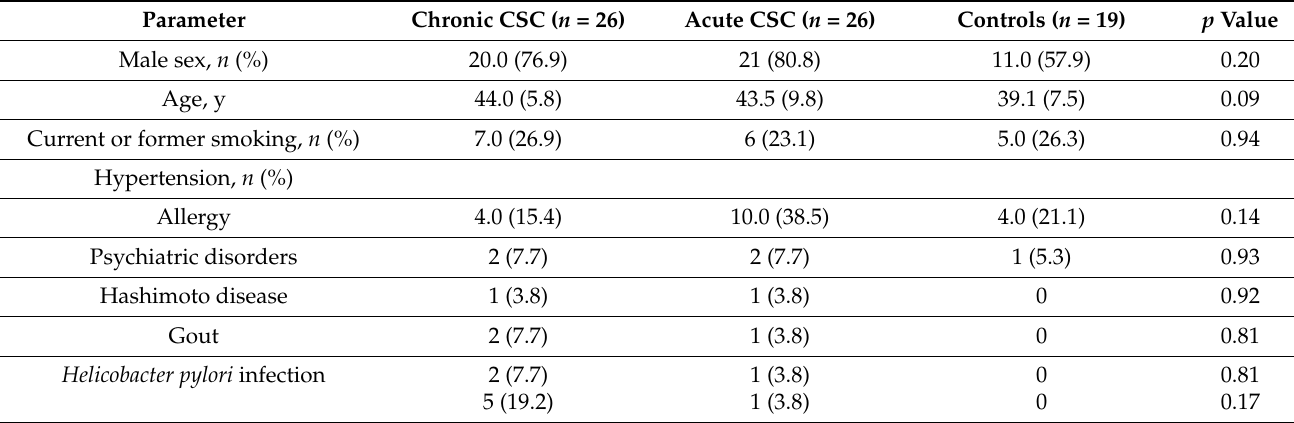
Table 1. Demographic and clinical characteristics of patients with acute central serous chorioretinopathy (CSC), patients with chronic CSC, and controls.